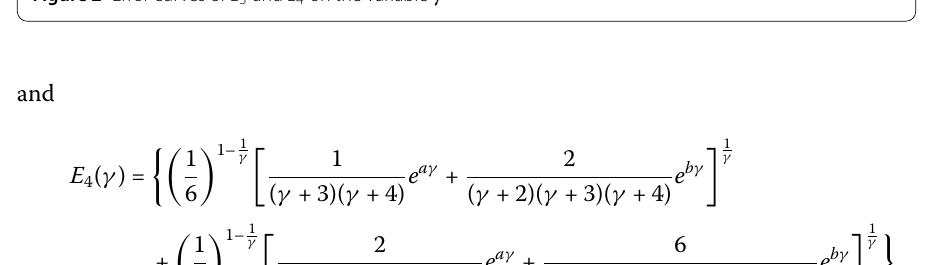
Figure 2 Error curves of E 3 and E 4 on the variable